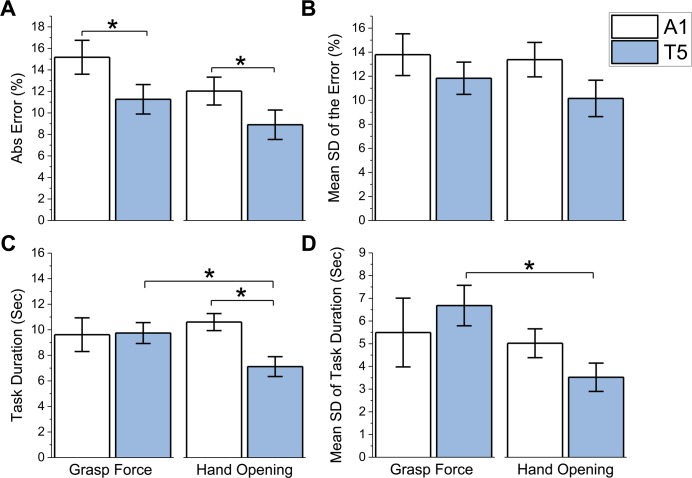
Performance on tasks requiring myoelectric control of grasp force and hand aperture.White bars: A1, Shaded bars: T5 A) Mean absolute value of the reach error B) Variability of the reach error data presented as the mean standard deviation of the reach error C) Mean task duration D) Variability of the task duration data presented as the mean standard deviation of the task duration. All results (N = 8) include their corresponding SEM. * indicates significant difference (p<0.05).